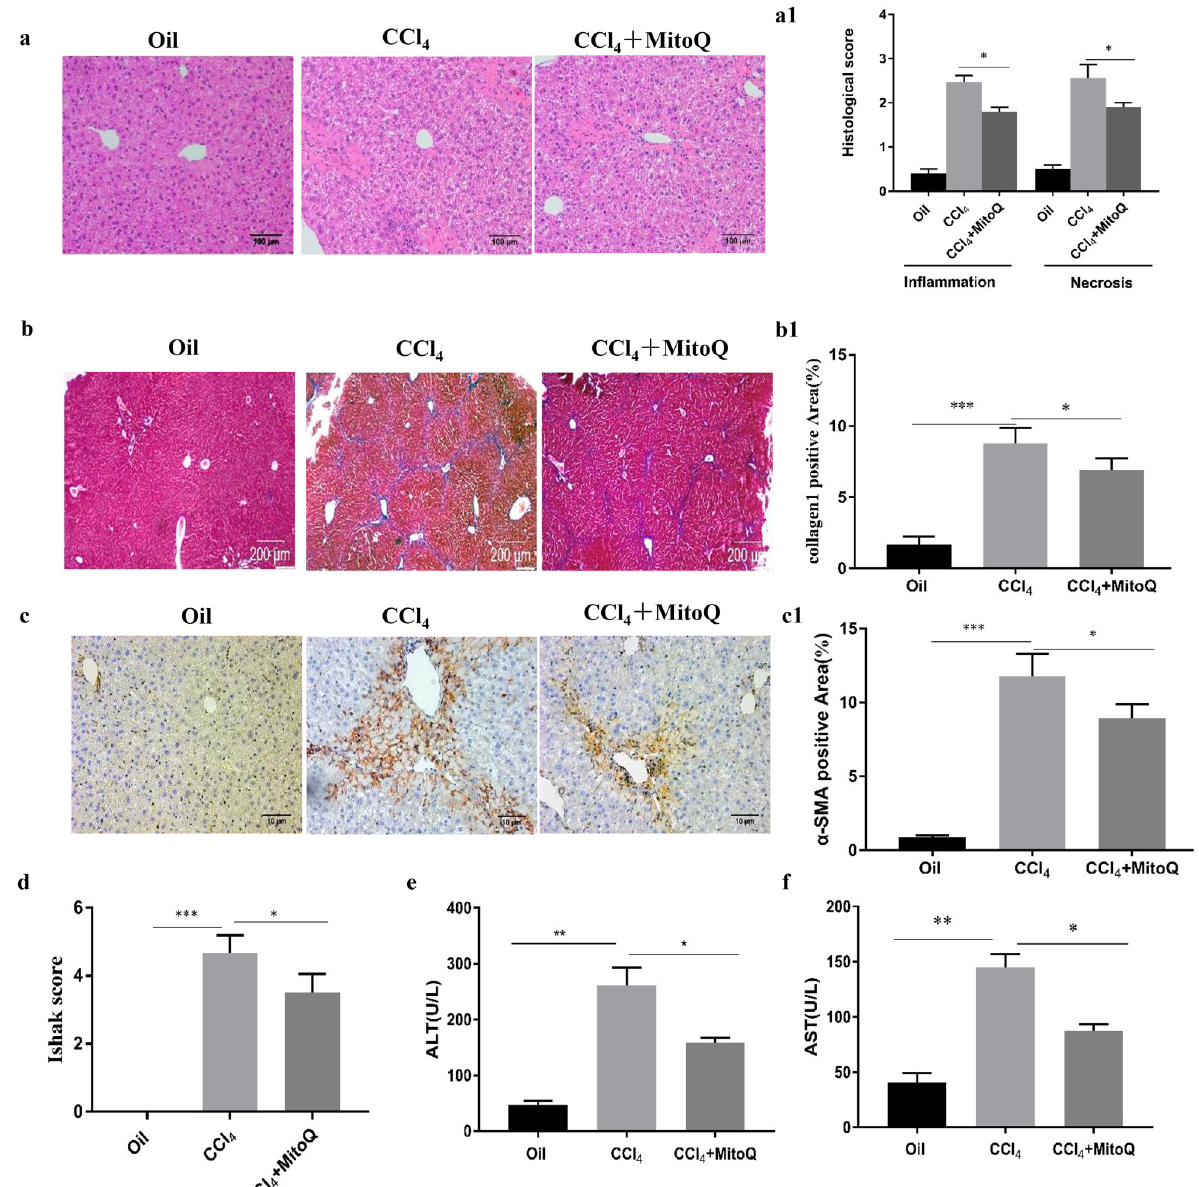
Figure 1: MitoQ inhibits mouse hepatic fi brosis. ( a ) Representative images of hematoxylin and eosin ( HE ) staining of liver tissue ( 100 × magni fi cation ) . ( a1 ) Quanti fi cation of liver in fl ammation and injury was performed. Results are presented as mean ± standard deviation. * P < 0.05 indicates signi fi cant di ff erences relative to the indicated groups; ( n = 6 ) . ( b ) Masson ’ s trichrome staining of the liver tissue ( 40 × magni fi cation ) ; ( n = 6 ) . ( b1 ) Columns represent the percentage of positive area of collagen fi bers. Results are presented as mean ± standard deviation. * P < 0.05, *** P < 0.001 ( n = 6 ) . ( c ) Immunohistochemistry for α - SMA in the liver tissue ( 100 × magni fi cation ) . ( c1 ) Columns represent the percentage of α - SMA positive area. Results are presented as mean ± standard deviation. * P < 0.05, *** P < 0.001 ( n = 6 ) . ( d ) Liver fi brosis semiquantitative scoring was performed. * P < 0.05, *** P < 0.001; ( n = 6 ) . ( e ) Serum ALT levels. * P < 0.05, ** P < 0.01 ( n = 6 ) . ( f ) Serum AST levels. * P < 0.05, ** P < 0.01 ( n = 6 )